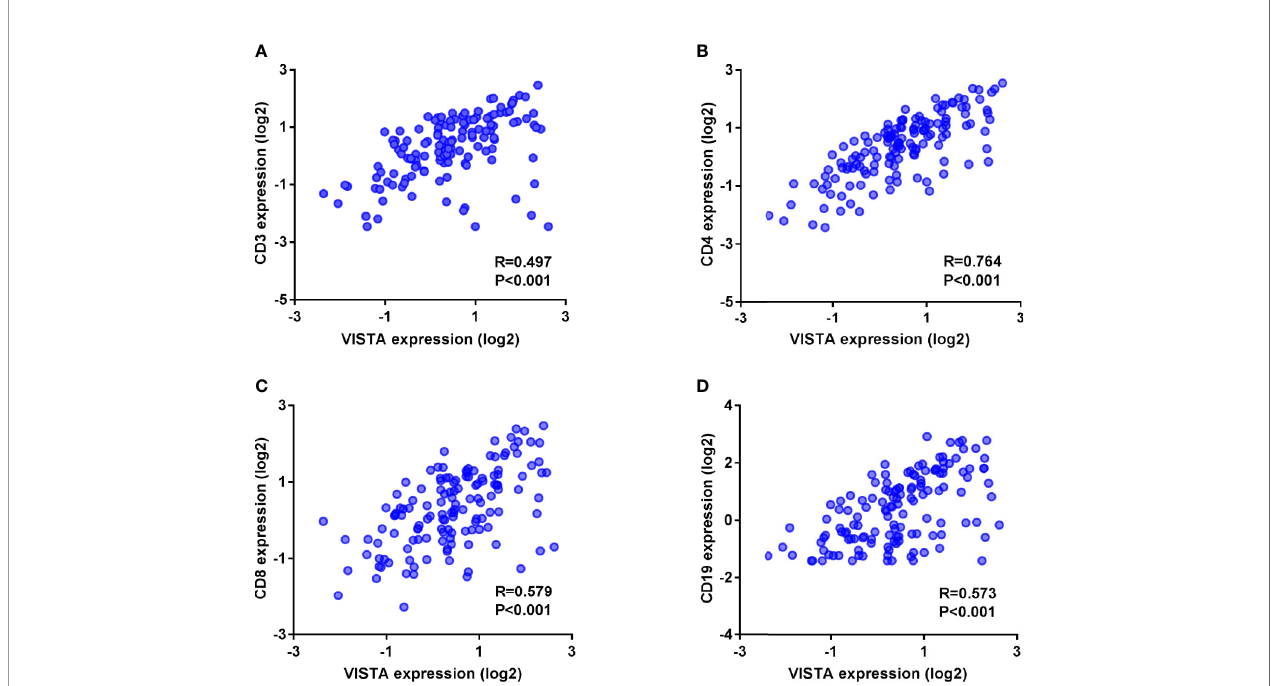
FIGURE 2 | V-domain Ig suppressor of T cell activation (VISTA)-encoding co-expressed with genes that encode CD3 (A) , CD4 (B) , CD8 (C) , and CD19 (D) in triple- negative breast cancer samples from The Cancer Genome Atlas public